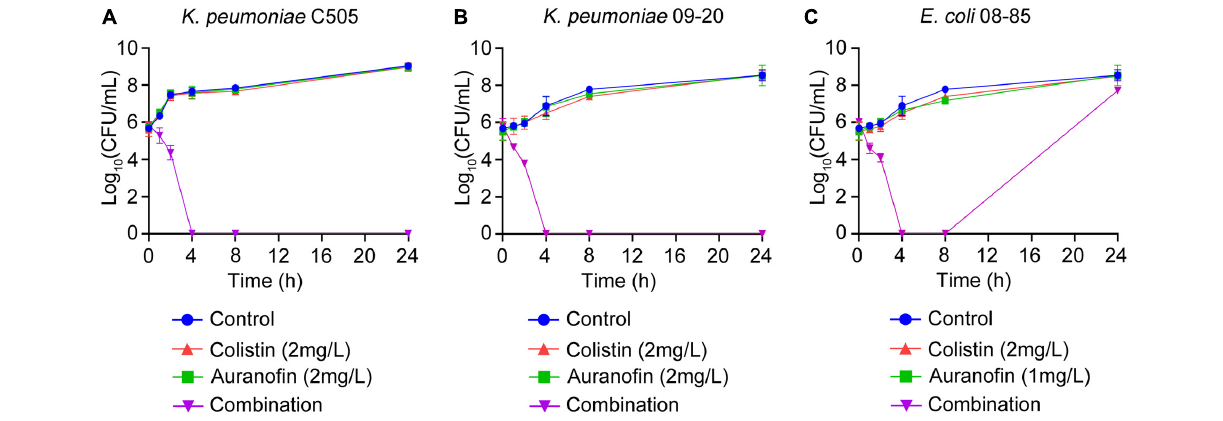
in cell length, and the cell surface was more uneven compared to the control group ( Supplementary Figure 1A ). For TEM, auranofin monotherapy ( Supplementary Figure 1G ) did not affected the cell surface. Membrane blebbing was observed with